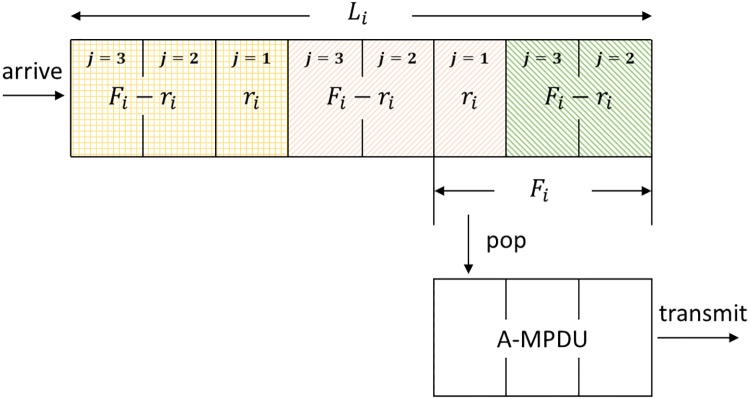
Example of a status for a queue [16–18].